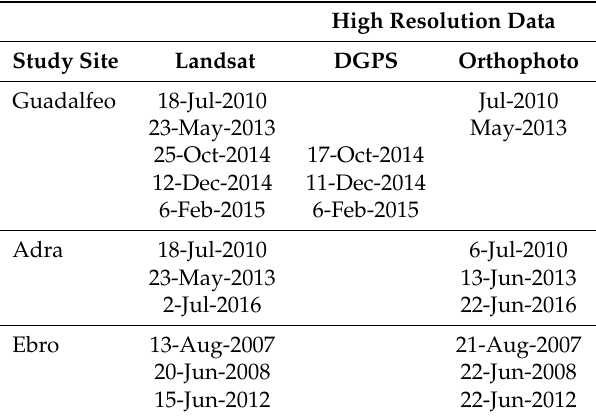
Table 2. Acquisition dates of data used in the study to asses the methodology.